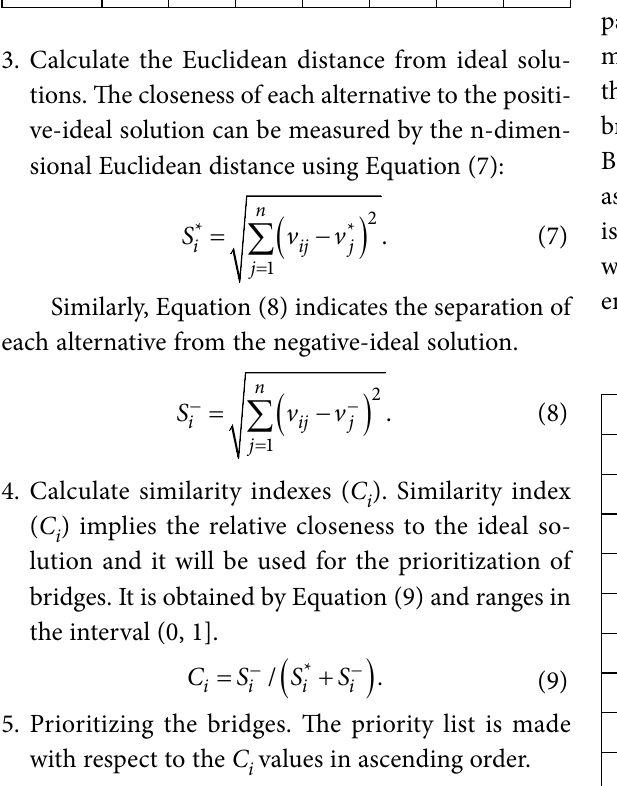
Table 8. Positive-ideal ( B * ) and negative-ideal ( B – ) solutions Solution SV